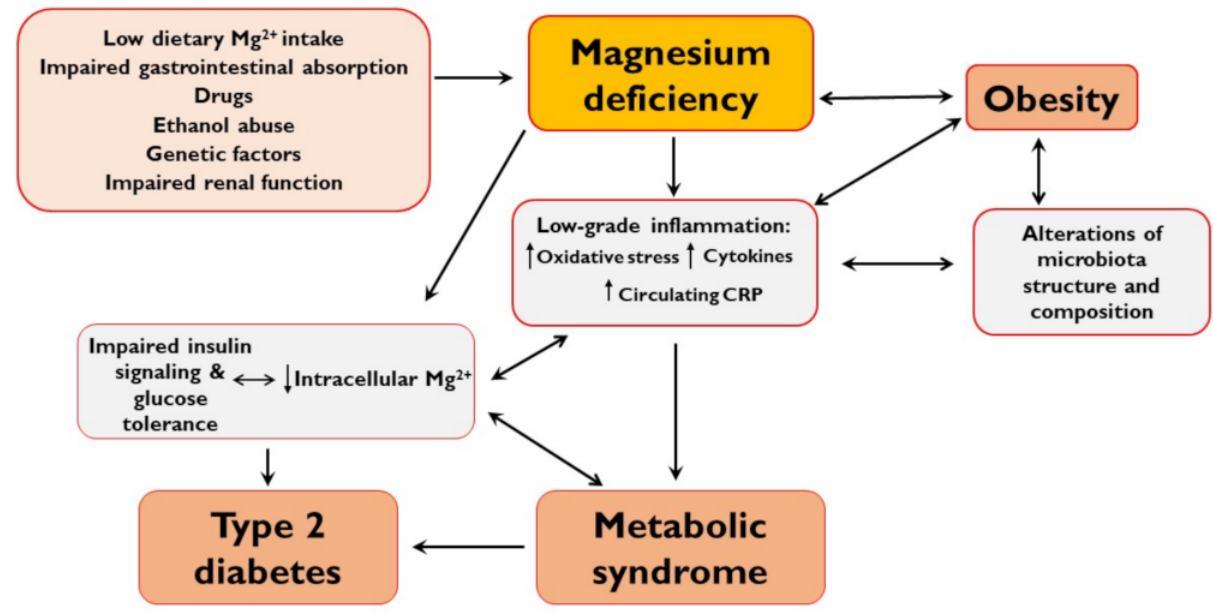
Figure 1. Physio-pathological mechanisms of magnesium deficiency in obesity, metabolic syndrome, and type 2